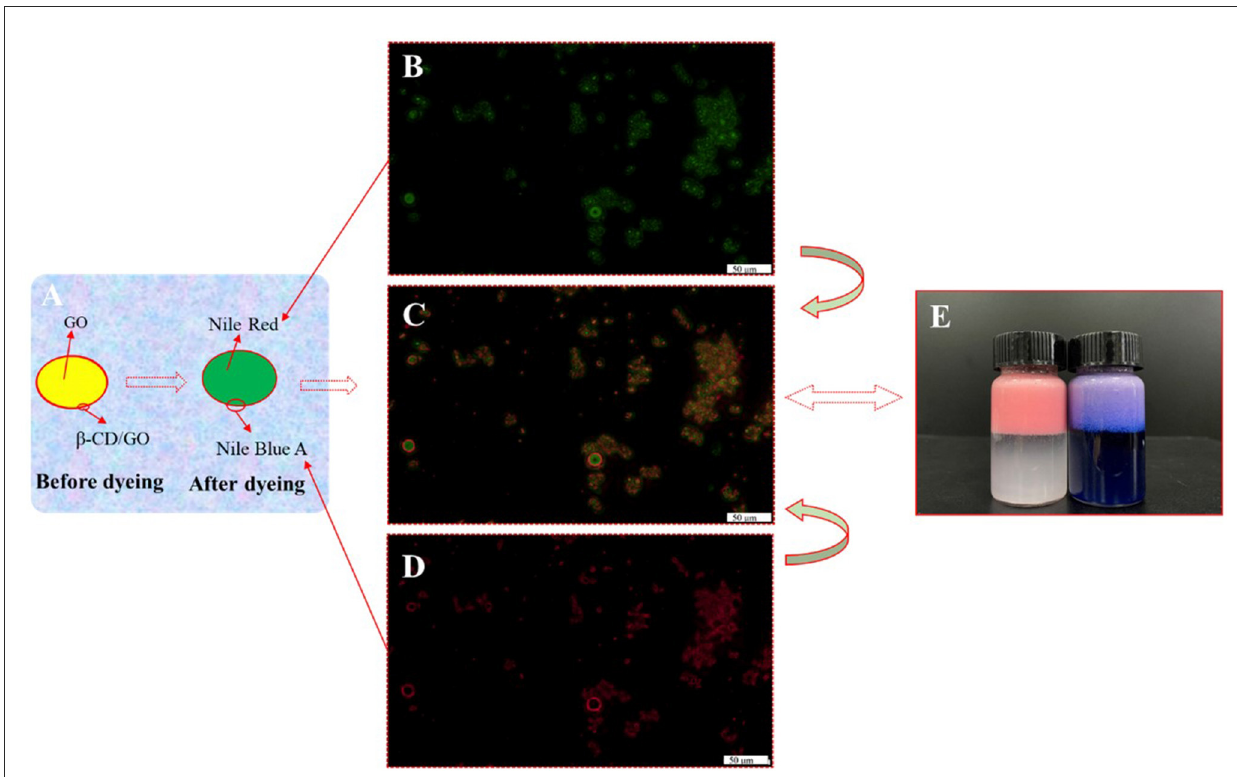
FIGURE7 Fluorescence micrographs of GO/ β -CD (1.25 wt%) Pickering emulsion. (A) The control model before and after staining; (B) was GO; (C) was the composite fluorescence image; (D) was the β -CD; (E) was the dyed emulsion after storage for 30 days (the left bottle was only dyed GO phase, and the right bottle was dyed both two phases).